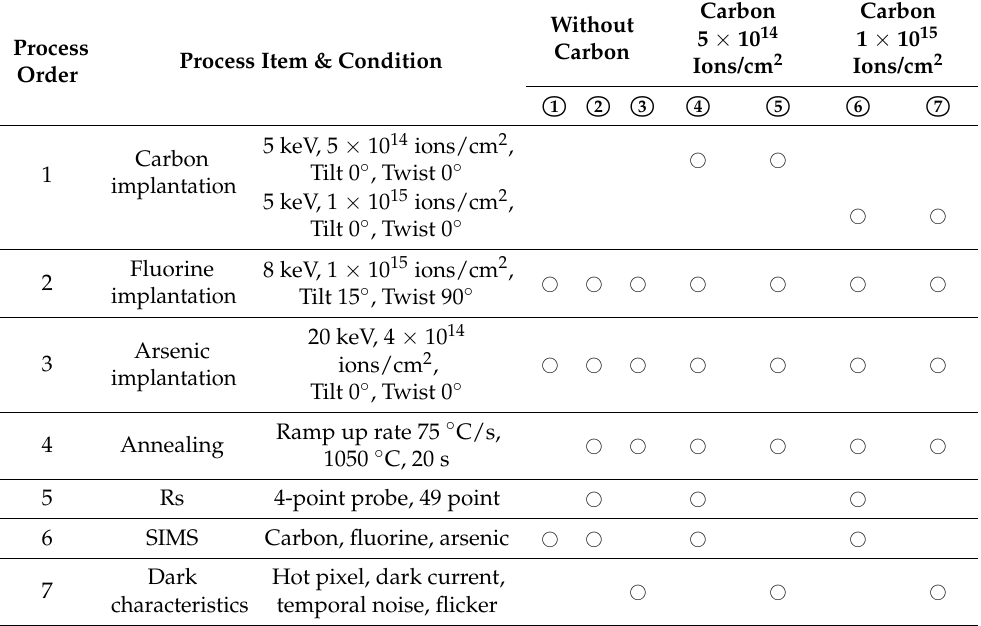
Table 1. Detailed implantation conditions and order with measurements of dark current characteris-